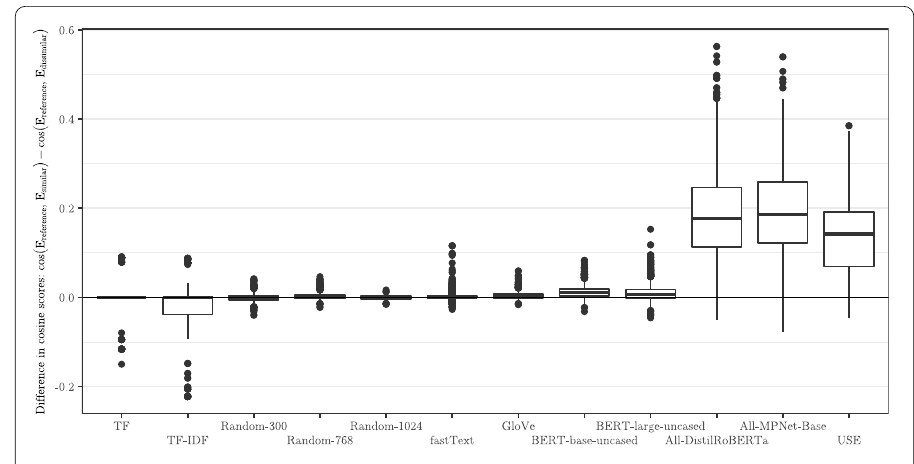
Figure 2 The distribution of the cosine similarity difference scores for Hypothesis 1 across text representation approaches. The y -axis indicates the size and direction of the differences. The more positive the difference scores are, the more support for convergent and discriminant